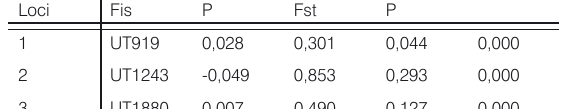
Notices: *- marked significant differences in average alleles sizes between highlanders and migrants; Private alleles in the groups are bolded; Differences between highlanders and lowlanders found for 6 of 8 loci (excepting UT2203 and UT919) (Z=6.8- 2.3; P=0.000-0.024); Differences between migrants and lowlanders found only for UT5030 and UT919 (Z=2.8. P=0.005 and Z=2.76. P=0.005) Table 4. Genetic Diversity among Three Groups Studied by Fixation Figure 4. Alleles distributions for loci UT1880, UT2092 and UT5030 indexes. among highland and migrant parts of the ‘split’ isolates in comparison with aboriginal